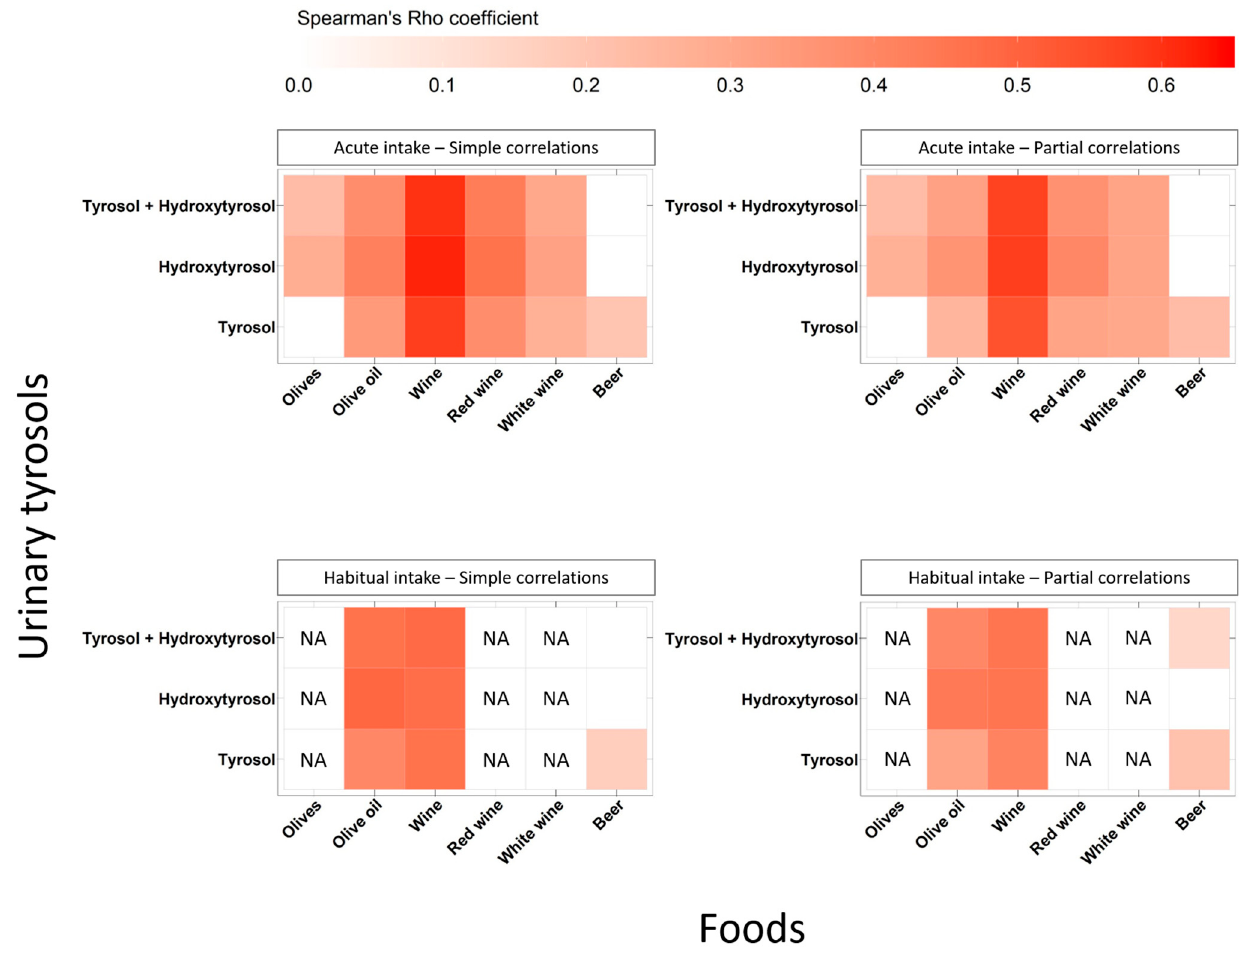
Figure 2. Heatmaps showing simple and partial Spearman’s correlations between urinary excretion of tyrosols and intake (acute and habitual) of selected tyrosol food sources. Abbreviations: NA, not available (i.e., correlation coefficients were not estimated due to lack of data on the habitual intake of these foods in all EPIC centers).